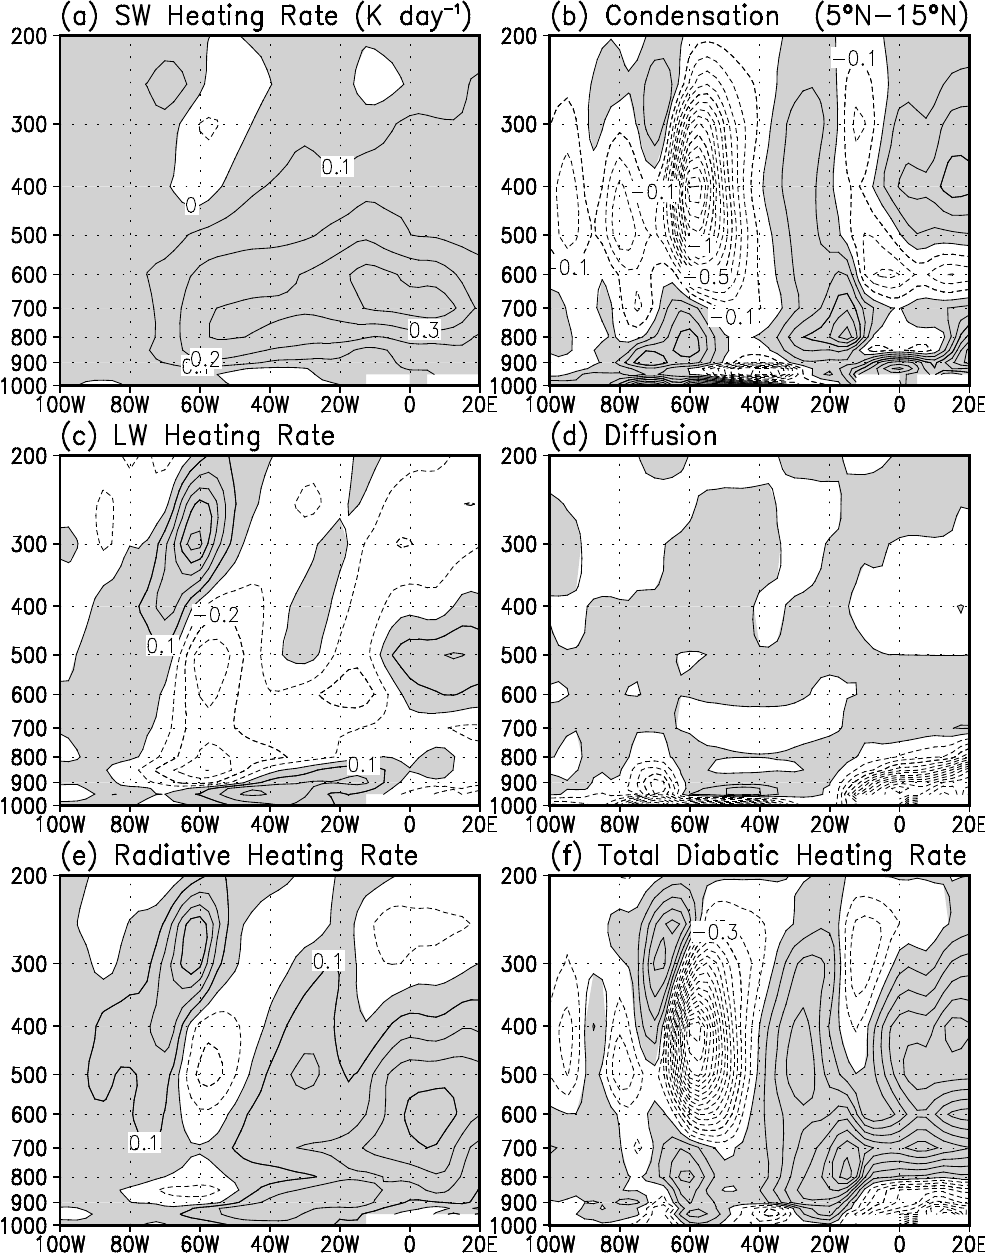
Fig. 6. Vertical zonal cross-section of heating rates for (a) shortwave, (b) longwave, (c) condensation, and (d) diffusion. Units of heating rate is in ◦ C per Figure 6 Vertical zonal cross-section of heating rates for a) shortwave, b) longwave, c) condensation, , and d) diffusion. Units of heating rate is in o C per day.